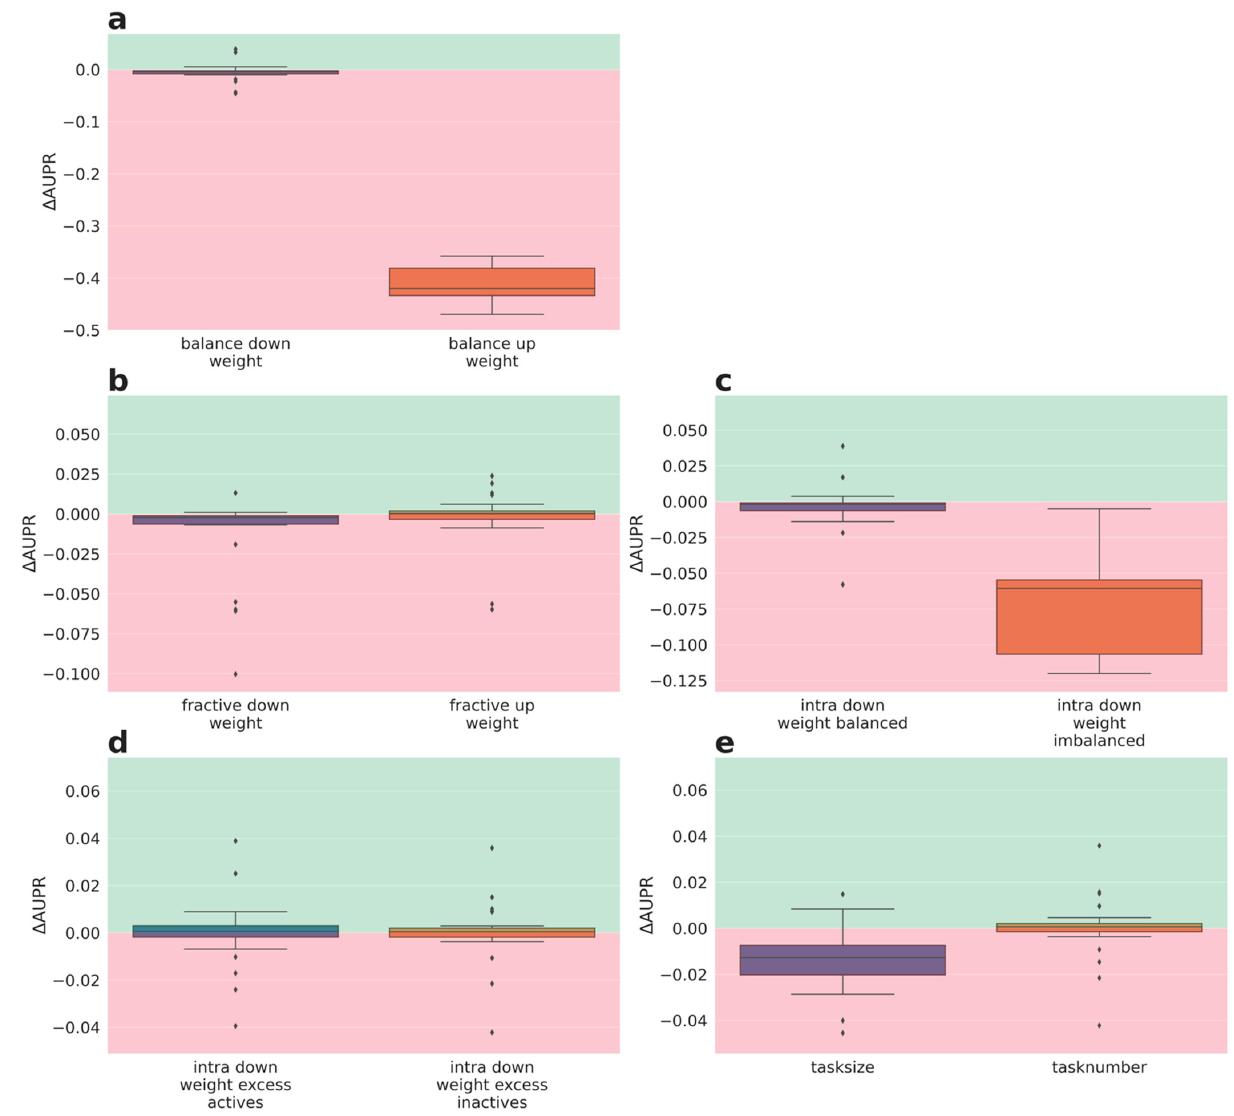
Figure 5. Phase III results averaged over 5 partners and 5 folds for lower quartile tasks performances (AUPR): ( a ) global weighting wrt. label balance, left: down-weighting balanced tasks, right: down-weight imbalanced tasks, ( b ) global weighting wrt. fraction actives, left: down-weighting excess of actives, right: down-weight excess of inactives, ( c ) intra assay weighting wrt. label balance, left: down-weighting balanced tasks, right: down-weight imbalanced tasks, ( d ) intra assay weighting wrt. fraction actives, left: down-weighting excess of actives, right: down-weight excess of inactives, ( e ) left: weight set wrt. number of datapoints, right: based on 1/task_number. Green: better performance than baseline (1), red: worse performance than baseline.